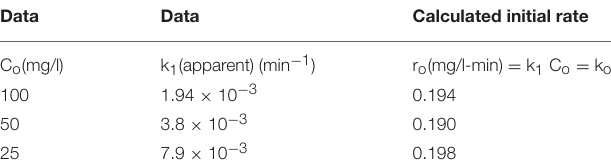
TABLE 1 | ZnO photocatalyzed oxidation of phenol Kawaguchi, 1984. Data